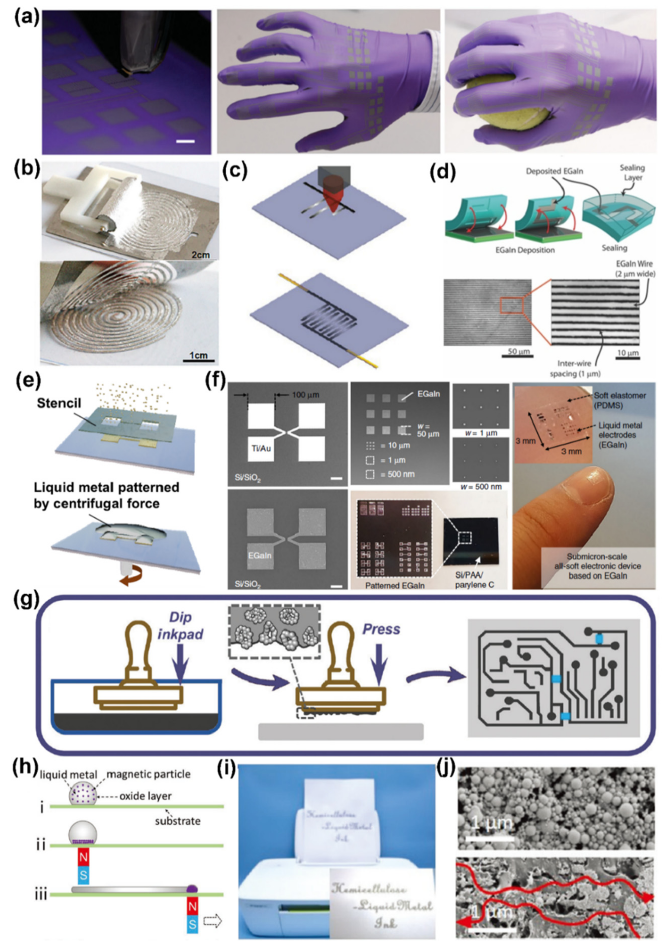
Figure 5. Printing methodologies of LM-based nano-composites. ( a ) Inkjet printing of LM nanopar- ticle-based inks. Reprinted with permission from Ref. [69] Copyright 2015 John Wiley and Sons. ( b ) The printing of Ni-LM on Eco-flex substrate via rolling brush. Reprinted with permission from Ref. [70] Copyright 2018 American Chemical Society. ( c ) The microcontact printing ( μ CP) of an LM- based circuit. Reprinted with permission from Ref. [72] Copyright 2018 American Chemical Society. ( d ) The deposition process of LM-based electronics with micro-scale line width. Reprinted with per- mission from Ref. [74] Copyright 2014 John Wiley and Sons. ( e ) The Stencil Lithography and Cen- trifugal Force-Assisted Patterning of Liquid Metal. Reprinted with permission from Ref. [75] Copy- right 2021 American Chemical Society. ( f ) Nanofabrication process based on hybrid lithography for submicron-scale LM patterning. Reprinted with permission from Ref. [76] Copyright 2020 Springer Nature. ( g ) Schematic image of the procedure for printing based on conductive LM nano-clay. Re- printed with permission from Ref. [80] Copyright 2021 Royal Society of Chemistry. ( h ) Direct pat- terning of LM using a magnetic field. Reprinted with permission from Ref. [81] Copyright 2019 John Wiley and Sons. ( i ) Image showing the printing of DAX/LM nano-inks on paper using a commercial inkjet printer. ( j ) SEM images showing that the printing path can be activated by the erasing method. Reprinted with permission from Ref. [82] Copyright 2021 Royal Society of Chemistry.